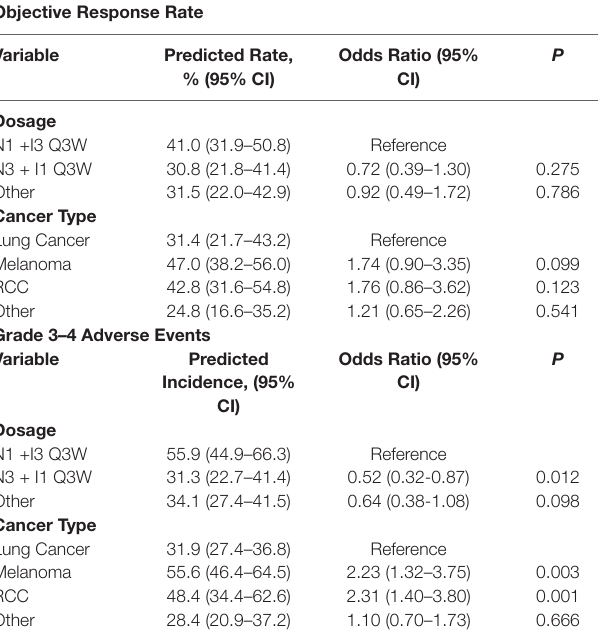
TABLe 2 | Meta-regression model results for objective response rate and grade 3–4 adverse